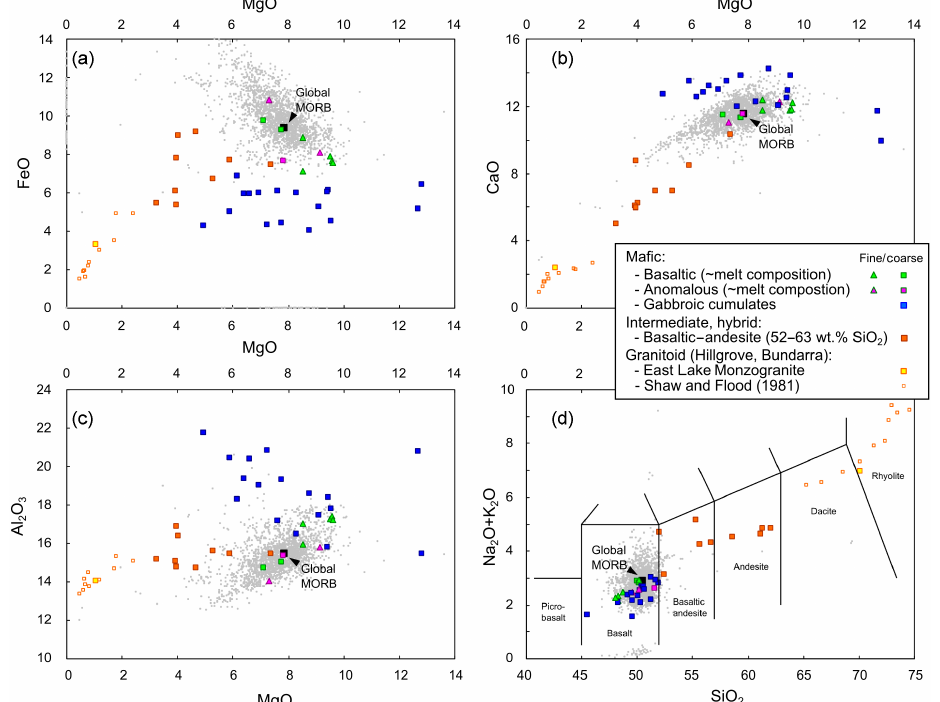
Figure 4. Major element chemistry of bulk samples. Finely crystalline, doleritic samples in triangles and coarsely crystalline samples in squares. Samples likely to represent melt compositions and anomalous samples (on the basis of unusual trace element contents; see Fig. 5) also likely to represent melt compositions are given in green and pink respectively. Cumulate gabbroic samples are in blue and mid-silica (compositionally basaltic andesite or andesite) rocks of probable hybrid origin (mantle–crust mixtures) are given in orange. Yellow squares indicate a single granitic sample of the East Lake Monzogranite (Hillgrove Suite). Other Hillgrove as well as Bundarra Suite samples from the classic study of Shaw and Flood (1981) are given as small orange squares. The global MORB identified by Arevalo and McDonough (2010) is presented as a large black square; MORB data from that study and from Jenner and O’Neill (2012) and the PetDB screening by Class and Lehnert (2012) are presented as small grey points. Fenner diagrams present MgO versus (a) FeO, with the trend defined by inferred melt compositions (in green field) indicating a tholeiitic association; (b) CaO; and (c) Al 2 O 3 . (d) Total alkalis vs. silica (TAS)